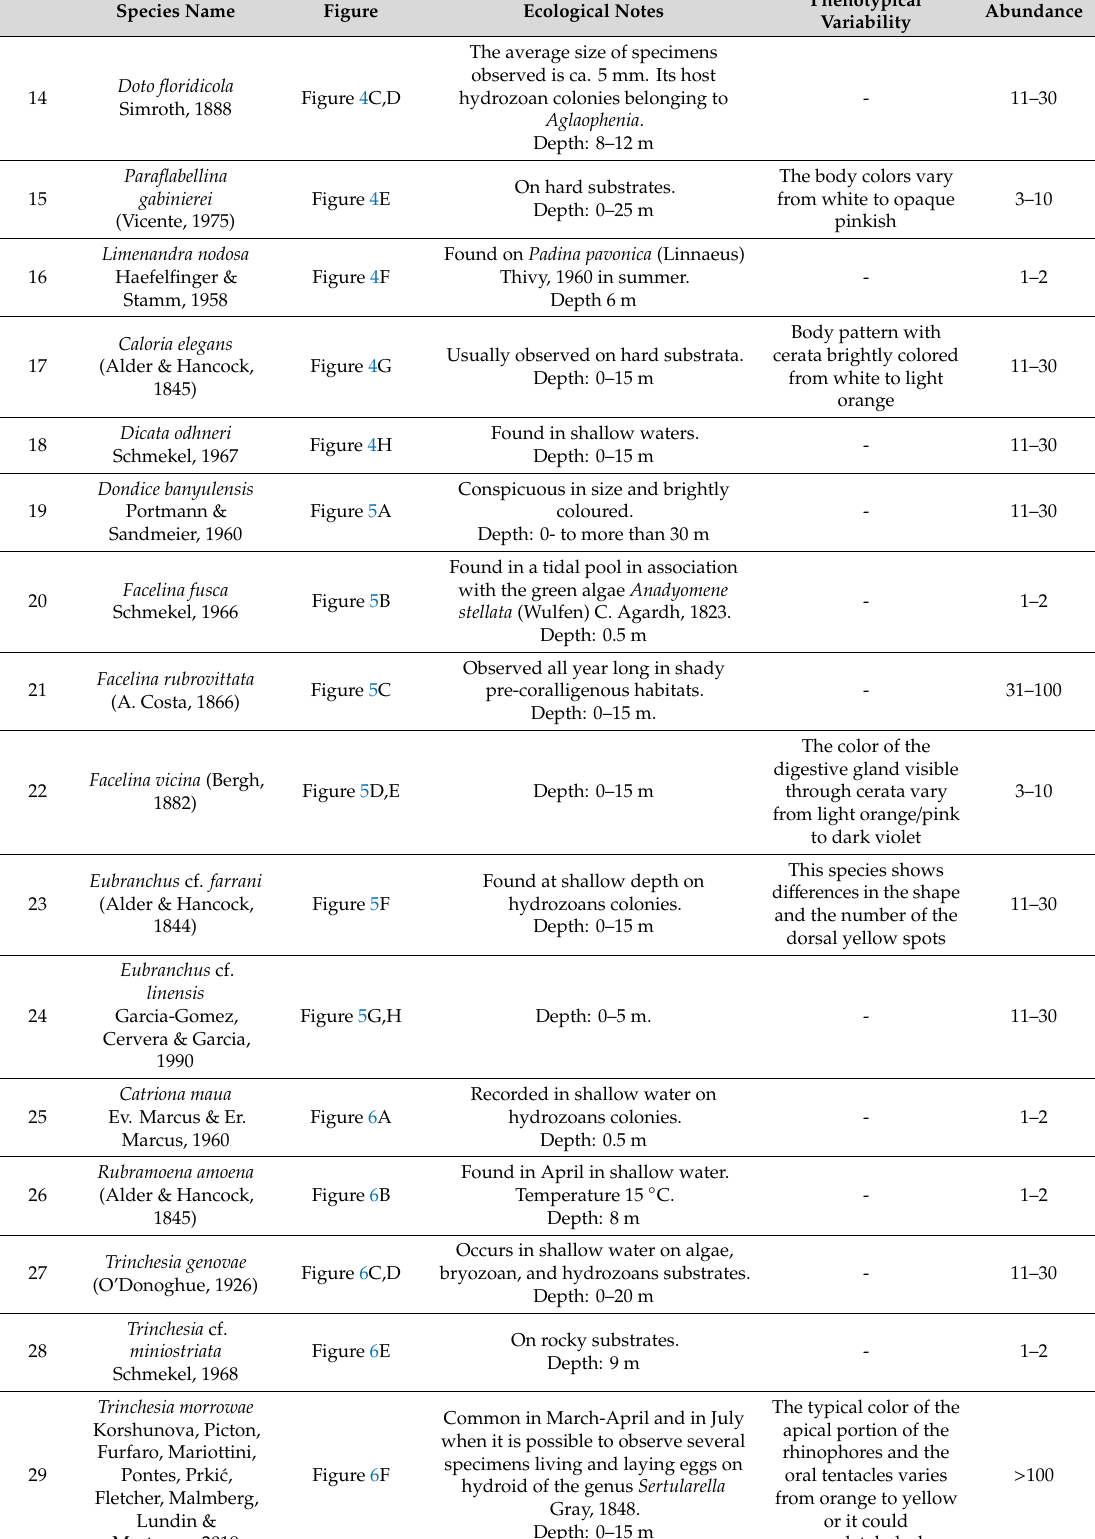
- 1–2 - 1–2 - 11–30 - 1–2 The typical color of the apical portion of the rhinophores and the > oral tentacles varies from orange to yellow or it could completely lack.